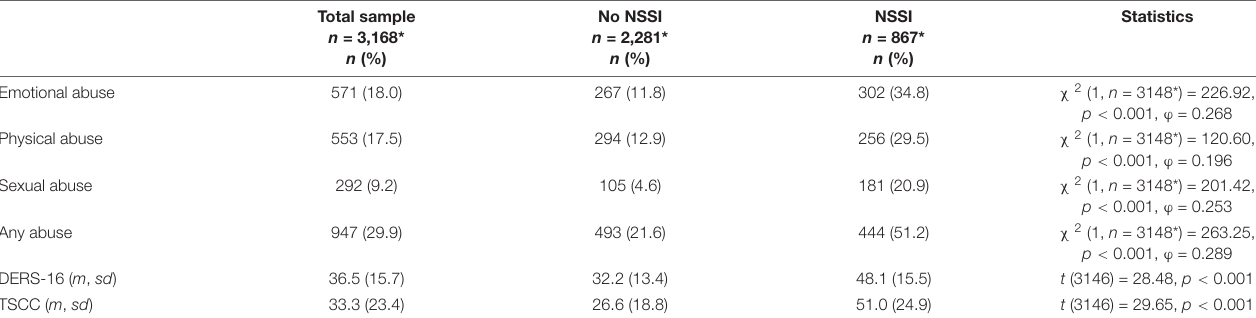
TABLE 2 | Frequencies and percentages of lifetime prevalence of childhood emotional, physical, sexual abuse in adolescents with and without NSSI, and means and standard deviations for trauma symptoms and difficulties with emotion